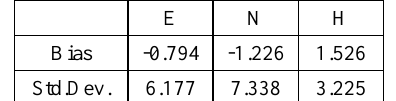
Table 7. The bias and the standard deviation of the differential DEM between the ZY-3 DEM and SRTM DEM (unit: